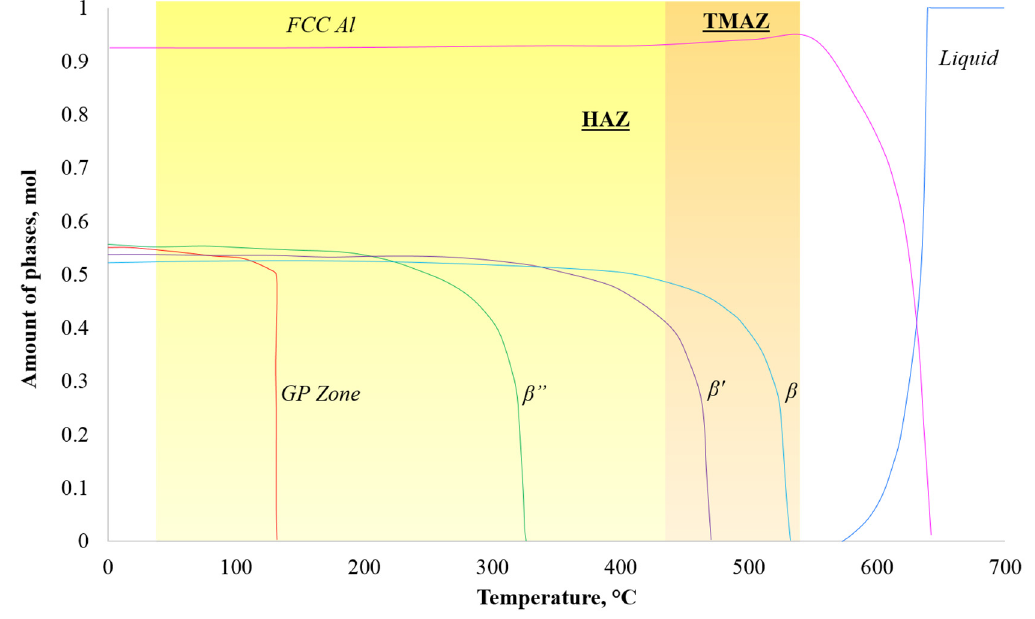
Figure 10. Phase dissolution curves for the AA6082 aluminium alloy.